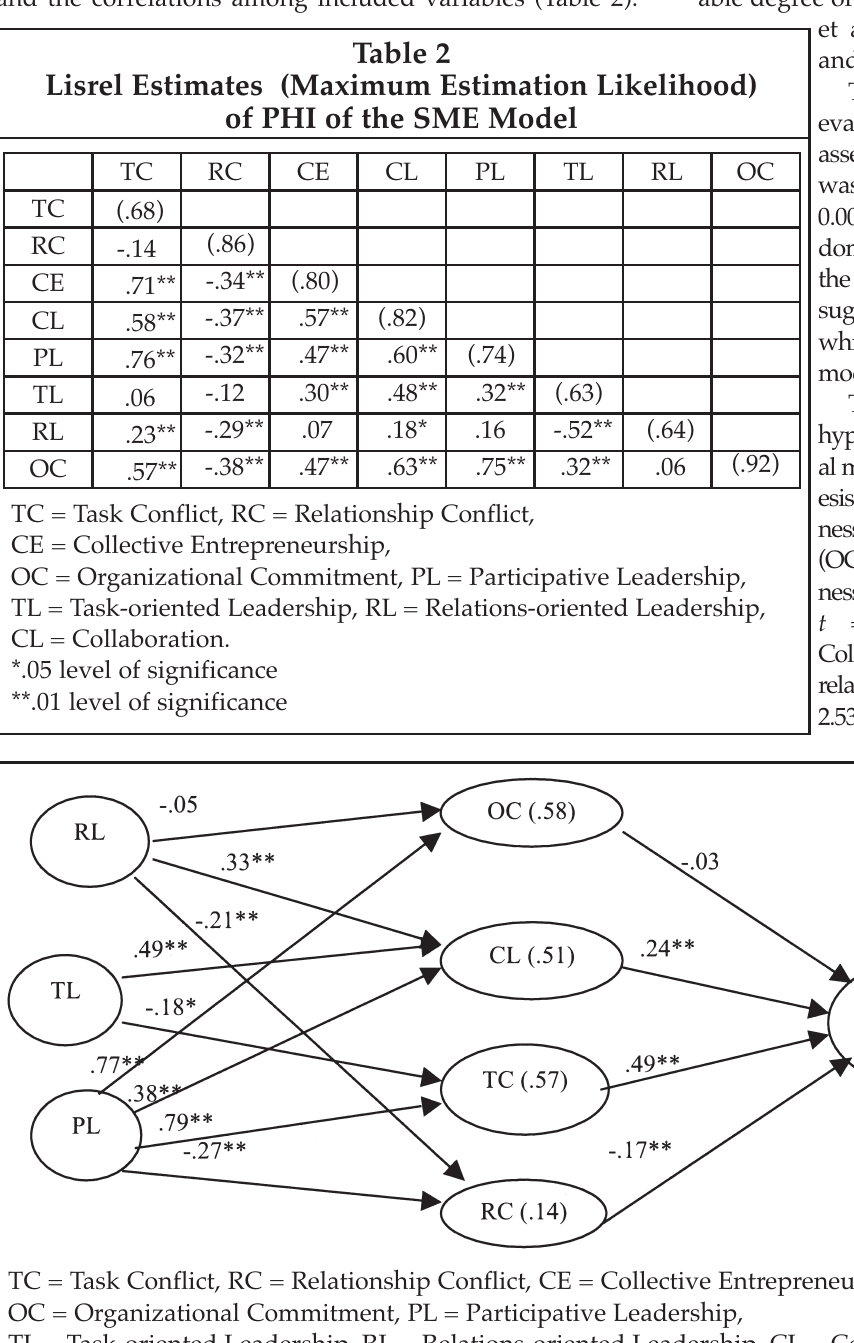
Figure 2. Results of SEM Analysis of the Hypothesized Path